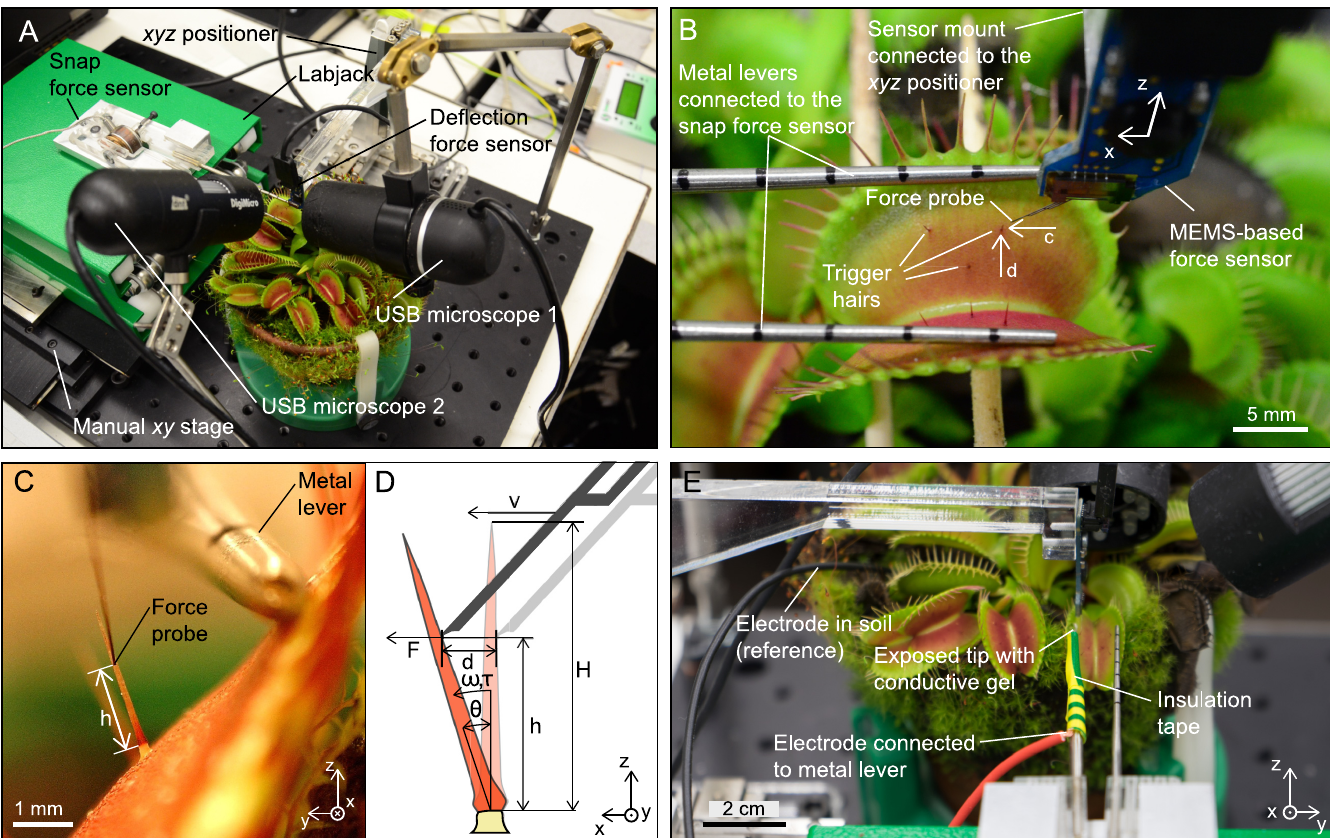
Fig 2. System configuration to investigate the necessary mechanical stimulation of the sensory hair triggering trap closure while measuring the resulting forces and APs. (A) The system combines a force probe to precisely control the deflection of sensory hairs and a second force sensor that measures the subsequent snap forces. Two USB microscopes are used to observe the experiment. (B) Close-up of the deflection force sensor used to deflect the sensory hair in direction parallel to the midrib. (C) View from the USB microscope 1 (on the right in A) used to extract the geometry of the sensory hair. (D) Schematic side view of hair deflection where the velocity v , the deflection d , and the force F are controlled and monitored. (E) For AP measurements, one electrode was connected to the metal lever and the other one inserted into the soil. AP, action potential; MEMS, microelectromechanical system; USB, universal serial